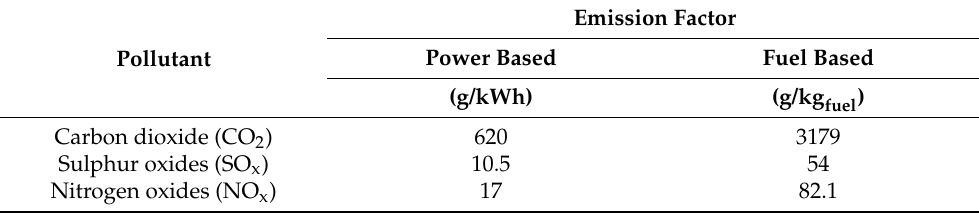
Table 3. Emission factors [15] for slow speed